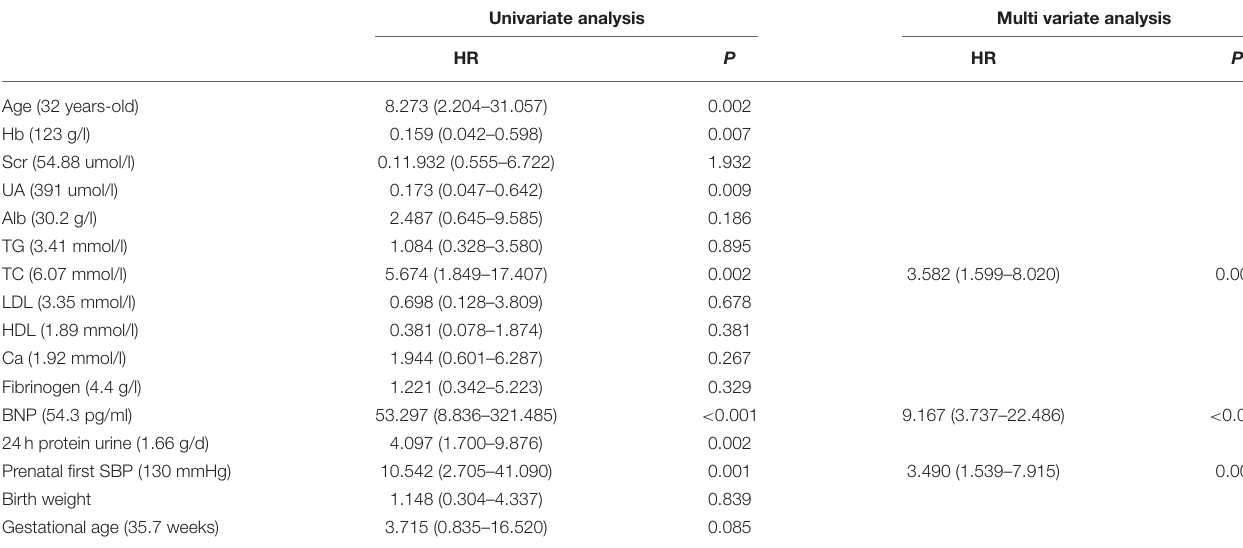
TABLE 3 | Logistic regression analysis risk factors for severe preeclampsia in patients with preeclampsia. Univariate analysis Multi variate